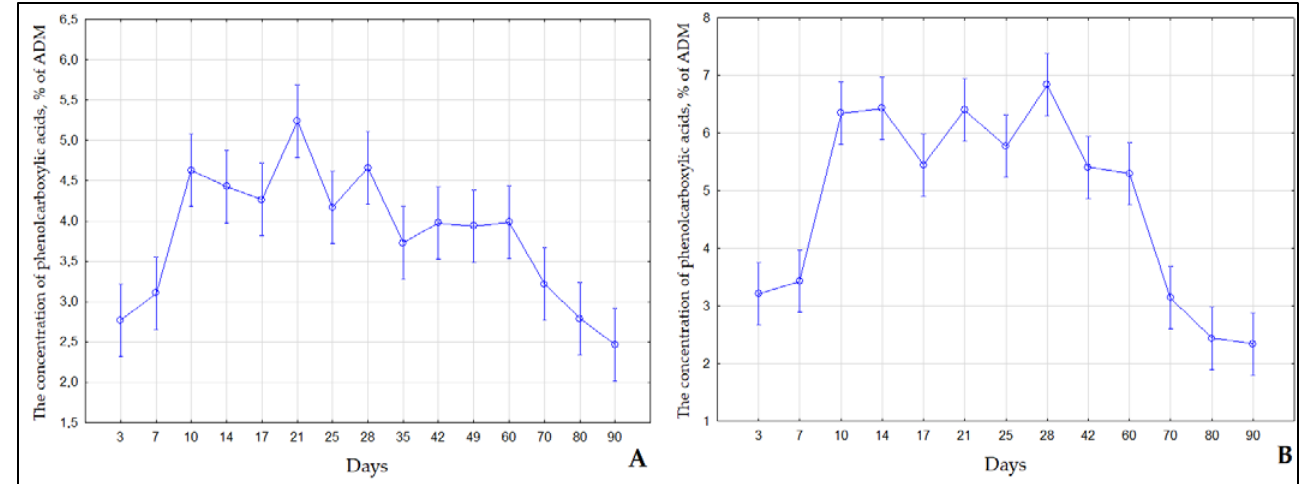
Figure 4. The concentration of phenol carboxylic acids in microshoots of S. betulifolia ssp. aemiliana cultured in ( A ) agar-solidified ( B ) and liquid media.